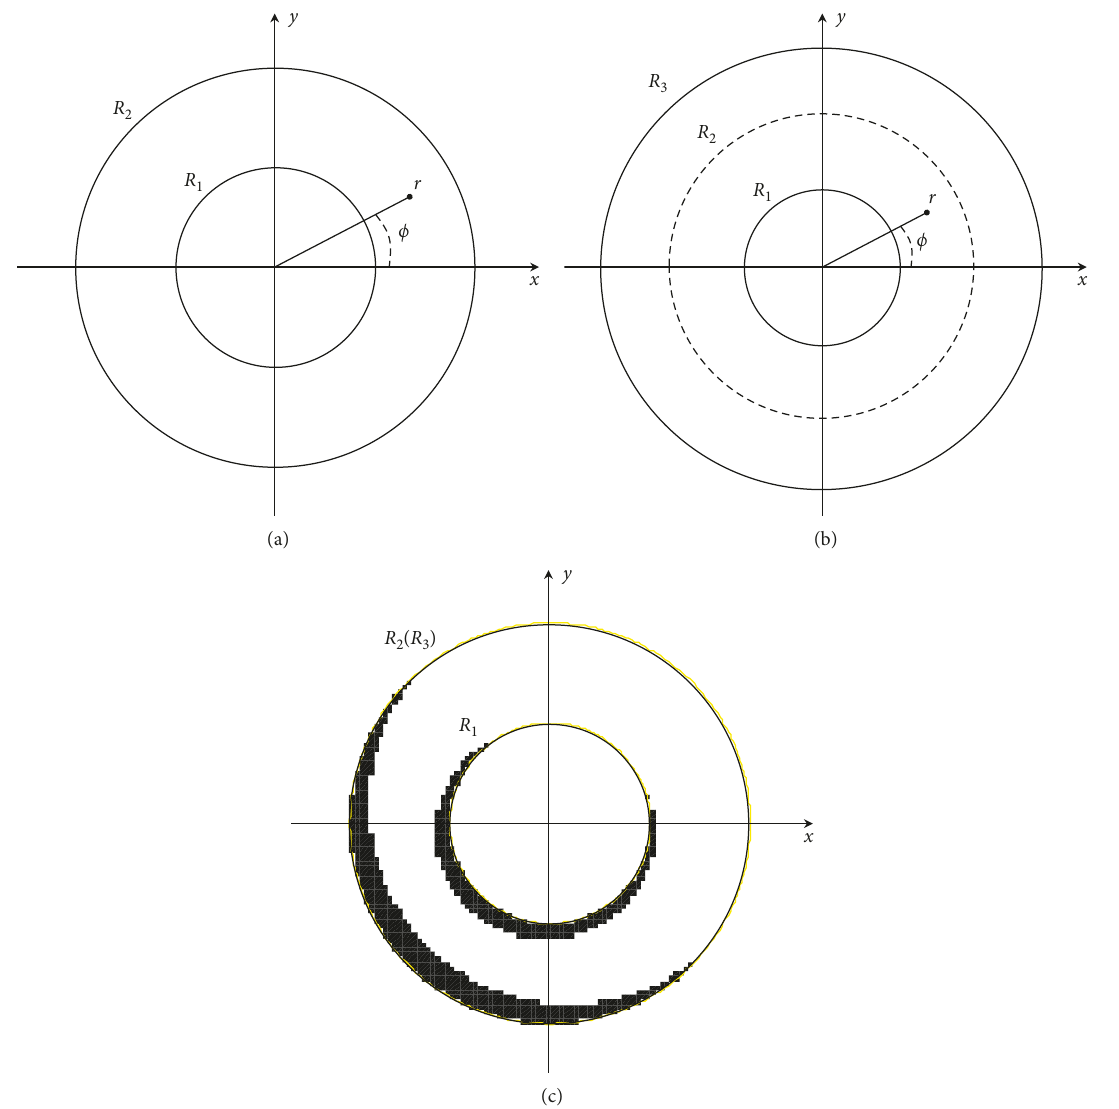
Figure 1: (a) Coordinates of the invisibility cloak and the field rotator, (b) coordinates of the field concentrator, and (c) the cells that are replaced with the background material to simulate boundary